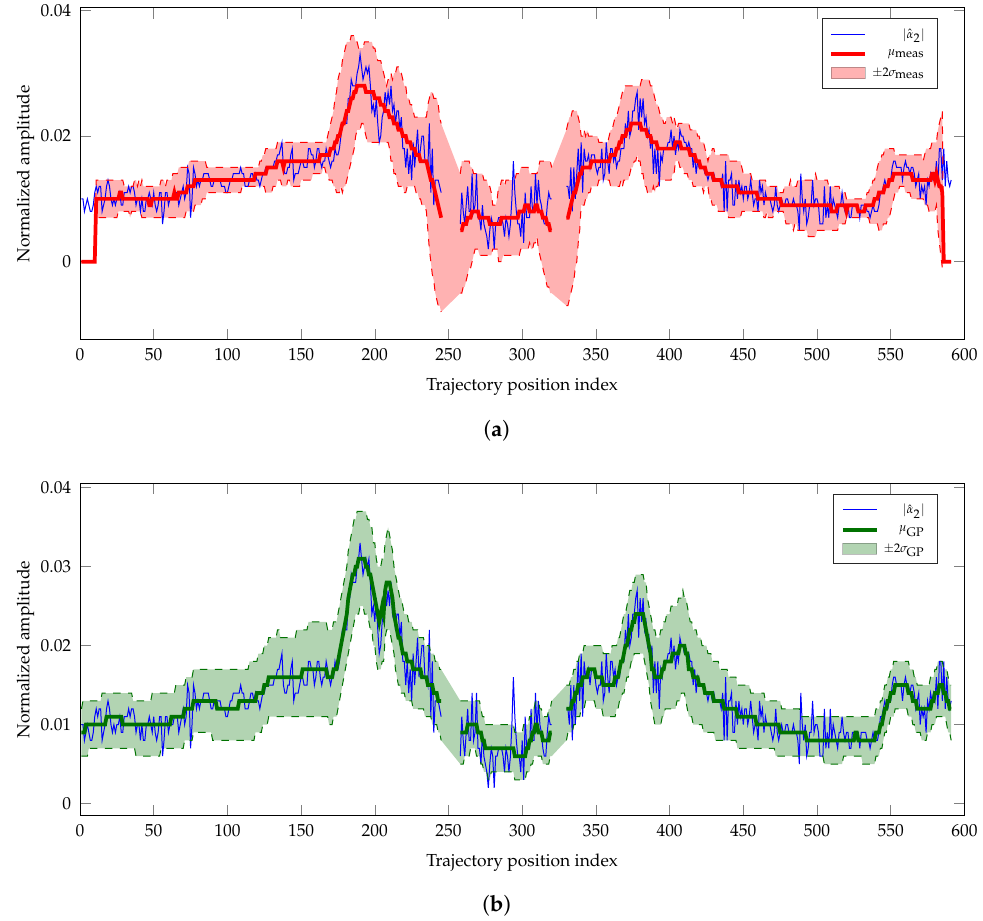
Figure 5. Estimated alpha compared to ( a ) measurement and ( b ) GP statistics ( a ( 1 )